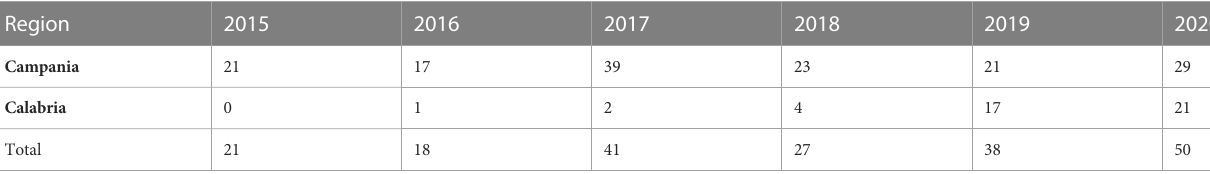
TABLE 1 Sea turtles examined in the Campania and Calabria regions from 2015 to 2020. Region